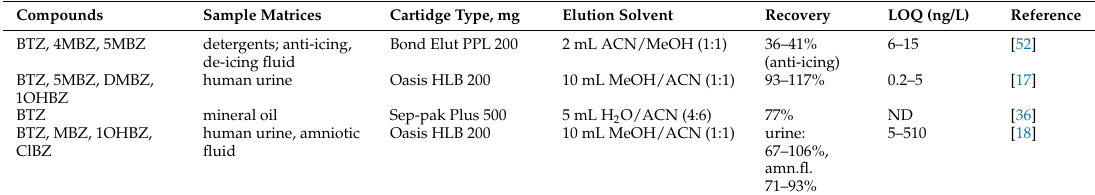
Oasis series and Sep-pak Plus are produced by Waters, Bond Elut by